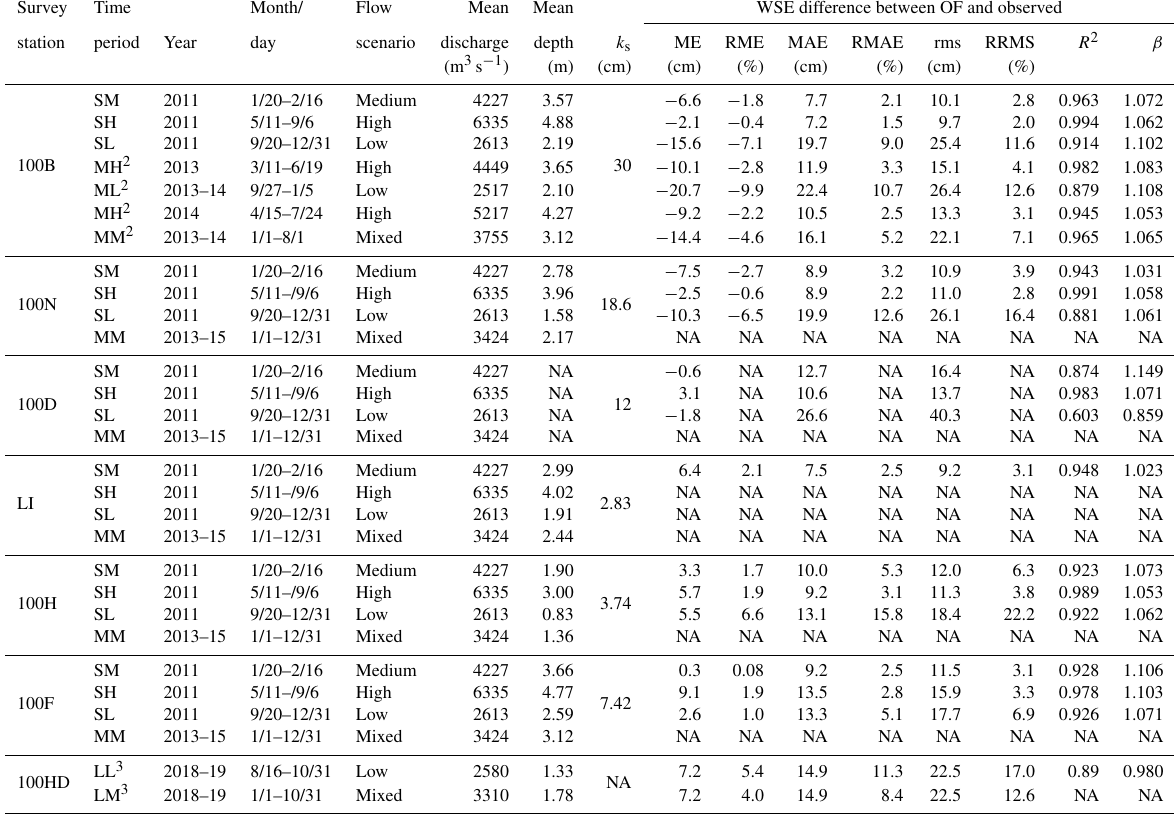
Table 2. A summary of flow scenario, discharge, water depth, roughness height, and modeling accuracy for calibration, validation, and